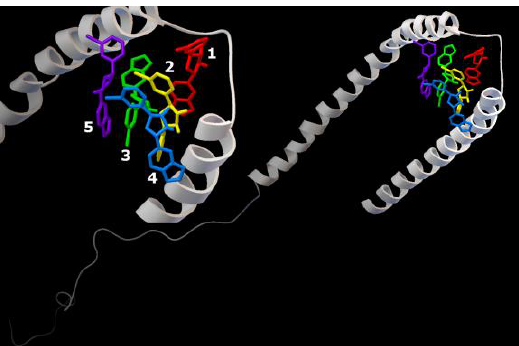
Figure 8. Five Anle138b ligand binding sites on micelle- bound AαSyn (PDB ID 1XQ8). Individual Anle138b ligands are as follows: 1 — red, 2 — yellow, 3 — green, 4 — blue, 5 — violet.